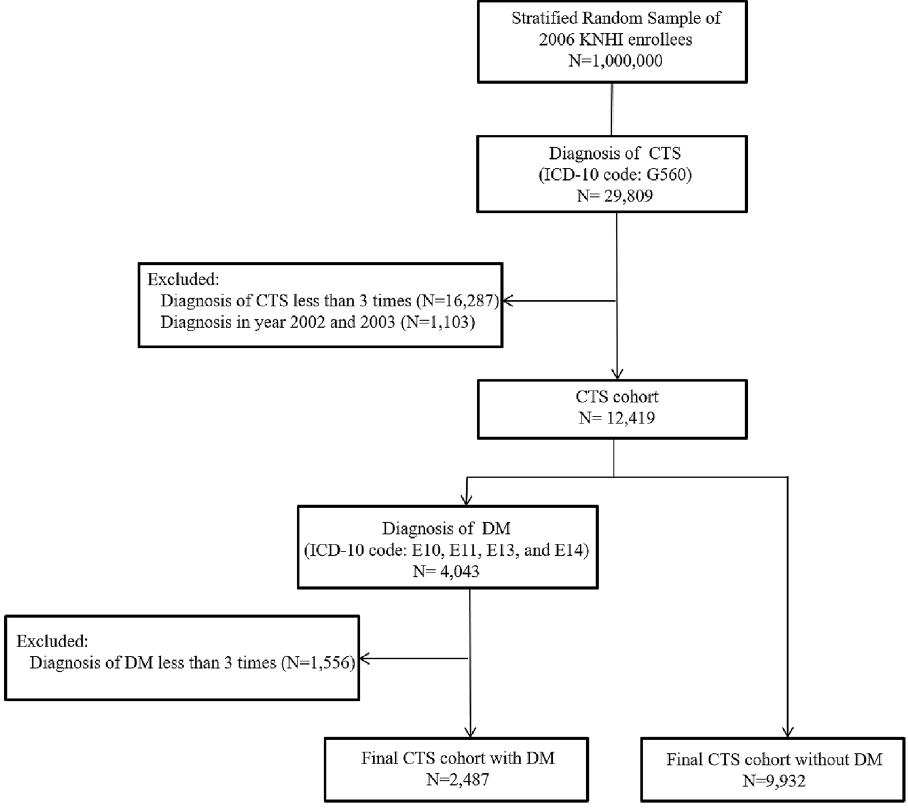
Figure 1. Flowchart for sample